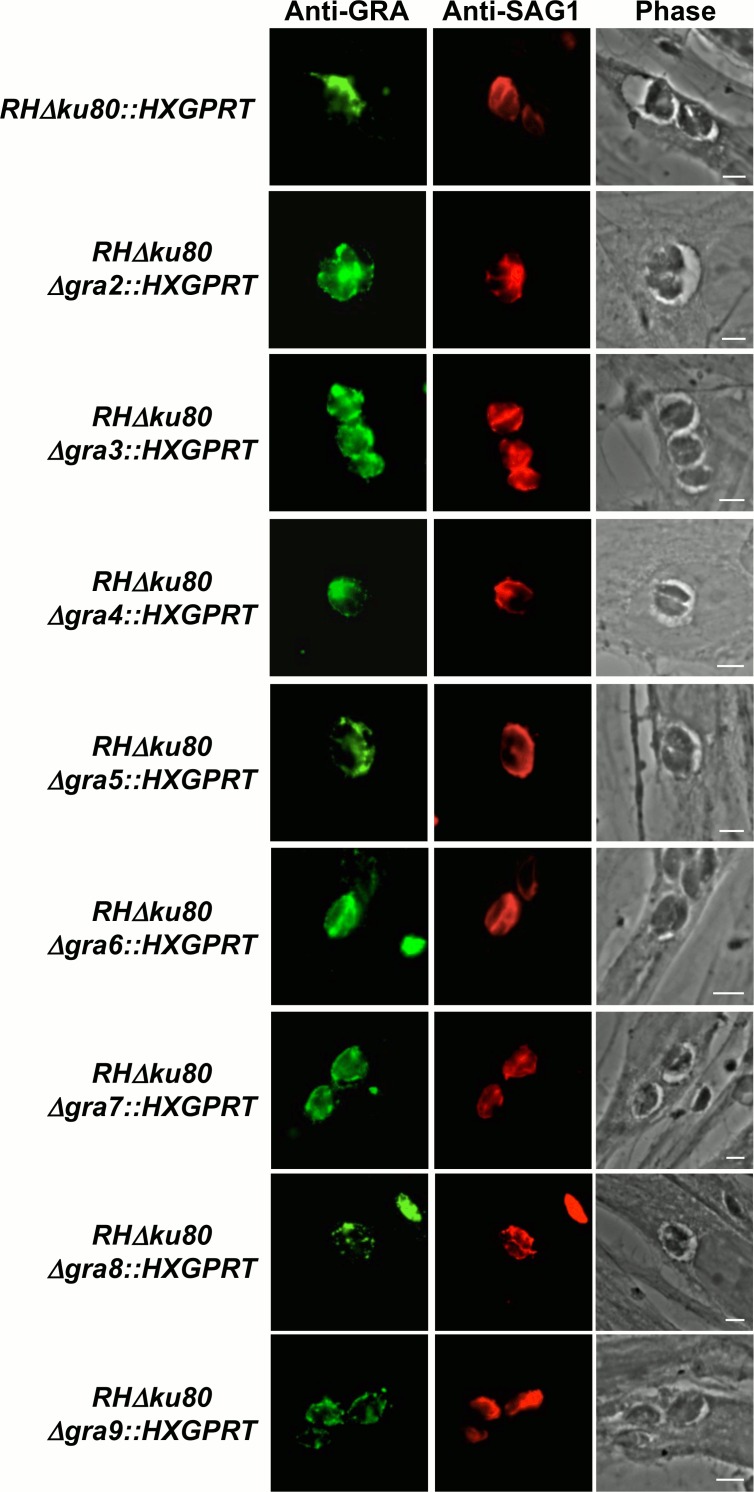
PV formation by Δgra2-9 single knockout strains in normal and lipid-free media.HFFs were pre-equilibrated in lipid-free D10 media (lfD10), then infected overnight with a single Δgra knockout parasite strain or the Δku80 parental strain. All parasite strains were passaged 3 times in lfD10 medium prior to infecting HFFs. Infected cells were fixed, permeabilized with 0.002% saponin, incubated with rabbit serum anti-GRA6 (all strains but Δgra6) or with rabbit serum anti-GRA4 (Δgra6) and with mAb anti-SAG1, visualized with goat anti-rabbit IgG coupled to Alexa 488 and goat anti-mouse IgG coupled to Alexa 594, mounted in Mowiol and observed by epifluorescence. To distinguish the shape of ∆gra mutants’ vacuoles in the absence of fluorescent signal, we chose to artificially increase their exposure time, which may lead to some background noise. Scales: 5 μm.